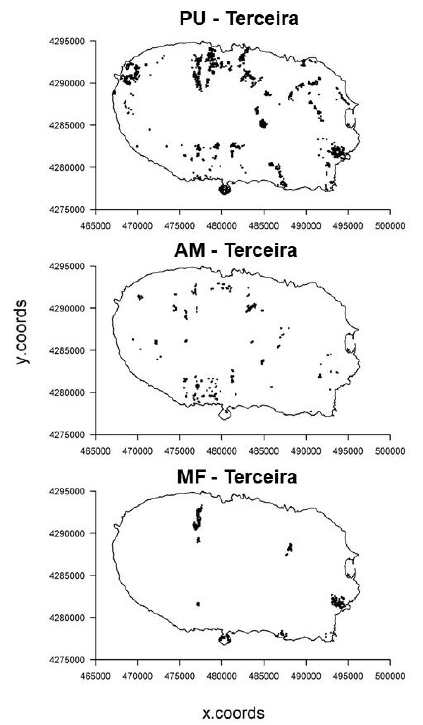
Figure 2. Species distribution data for P. undulatum (PU), A. melanoxylon (AM), and M. faya (MF) in Terceira Island.